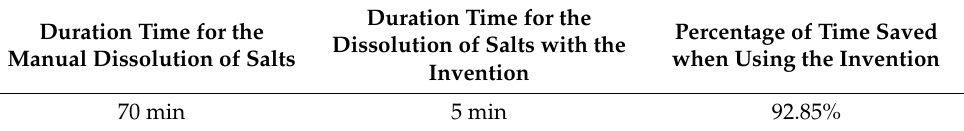
Table 3. Data of time saved as a result of using the invention between manual and automatic equipment for dissolving solid fertilizers.